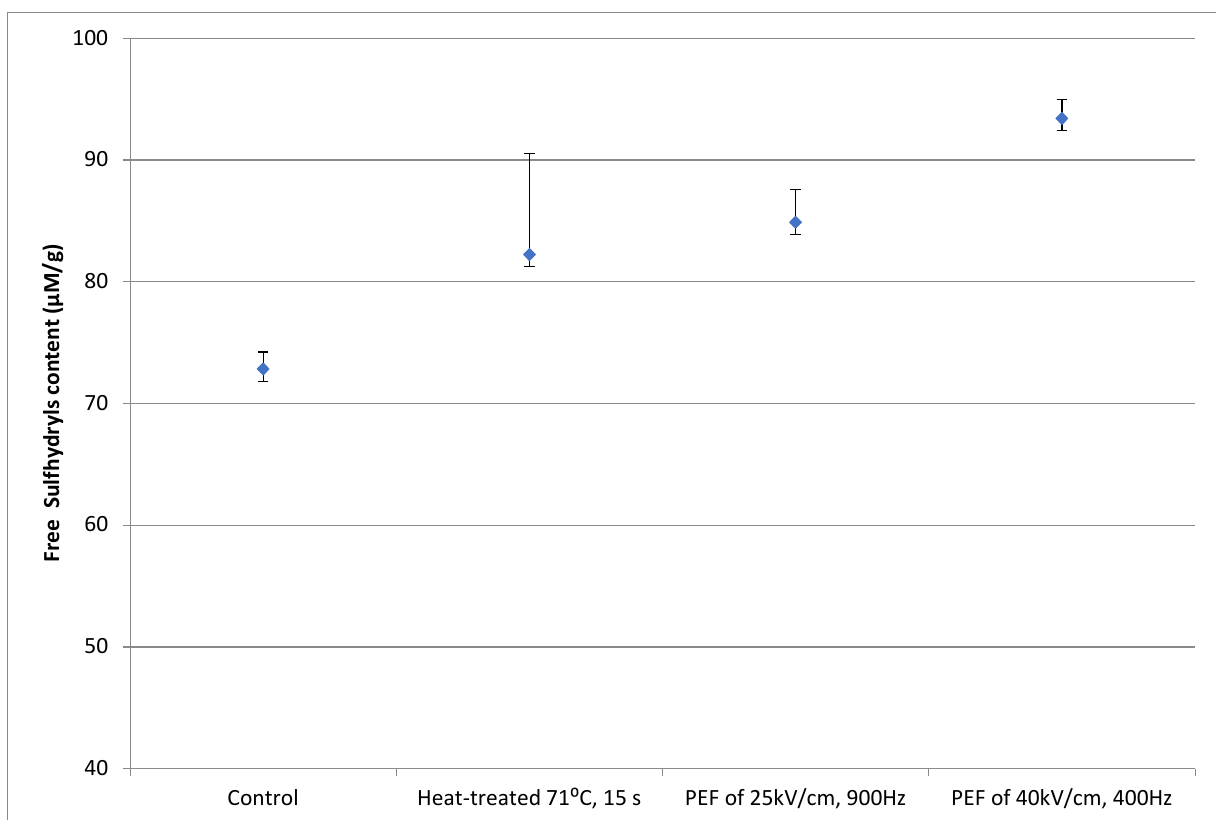
Figure 10. Free surface sulfhydryl content of soy protein isolates (SPIs) dispersions treated with different PEF conditions and thermally treated at 71 °C for 15–20 s. The results are presented as a mean of duplicate samples, and the numbers above each point represent the standard deviation of each data point.